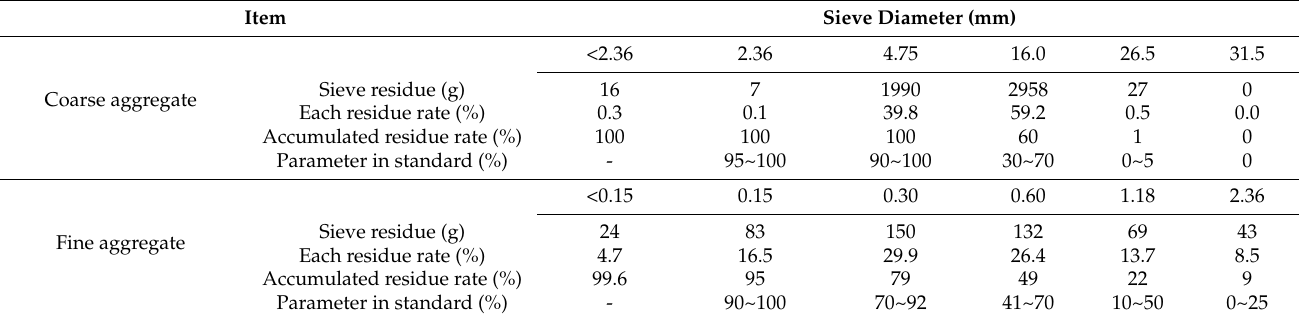
Table 2. The particle size distribution of coarse aggregate and fine